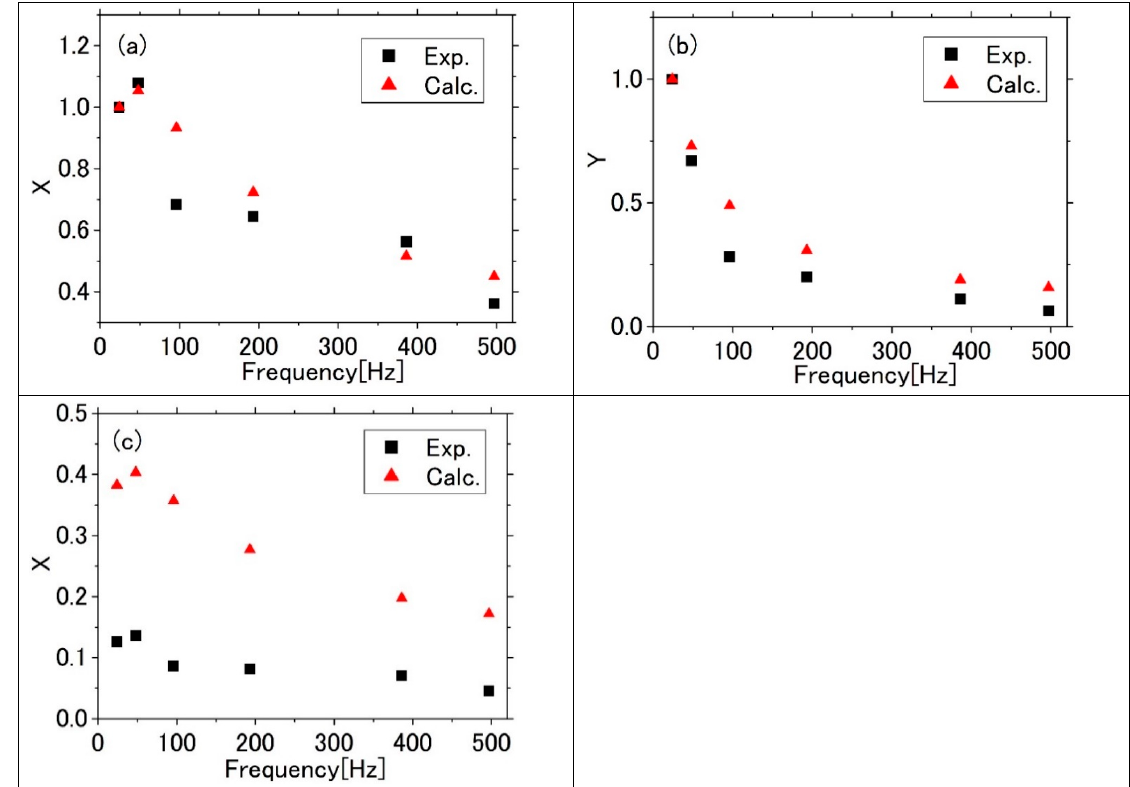
Figure 10. Frequency dependence of ( a ) X and ( b ) Y components in the electro-modulation spectra and in the calculation from Equation (12) with phase advanced by π . For both X and Y , the magnitude is normalized to 24 Hz. ( c ) Frequency dependence of X in the electro-modulation spectra and in the calculation from Equation (12) with phase advanced by π normalized to the magnitude of 𝑌 at 24 Hz.